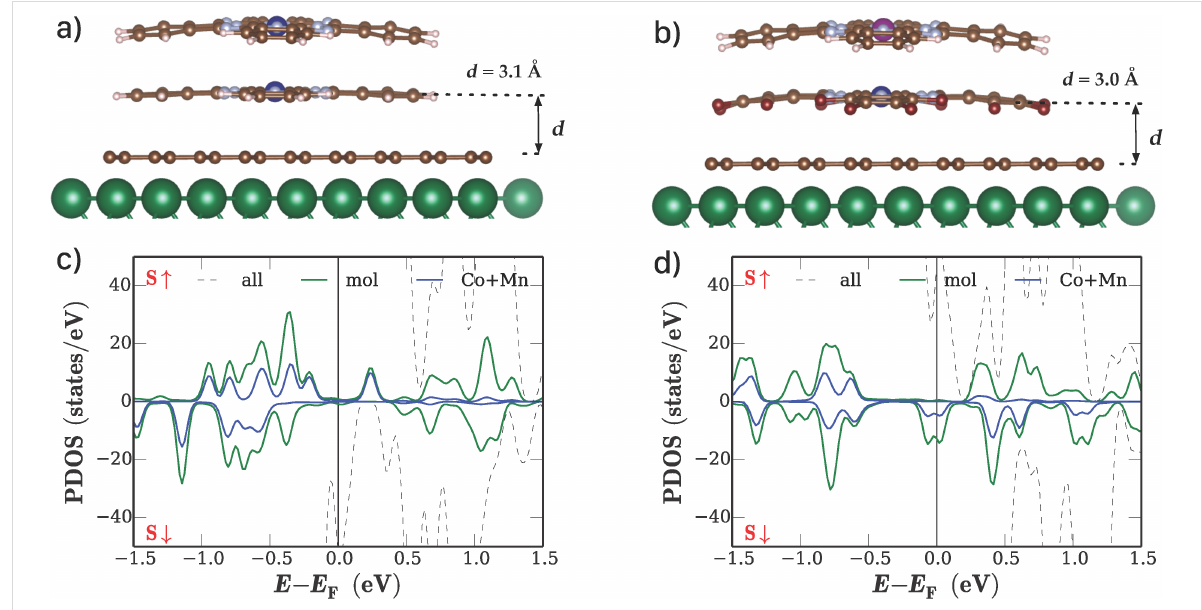
Figure 3: Results of DFT calculations for phthalocyanine stacks on fcc-Ni(111) surfaces: relaxed geometries of a) the CoPc/CoPc stack and b) the F 16 CoPc/MnPc stack. c), d) DOS of the molecule-Au(111) interfaces as obtained from the calculations. The overall DOS as well as the projections onto the molecule and metal centers are shown.